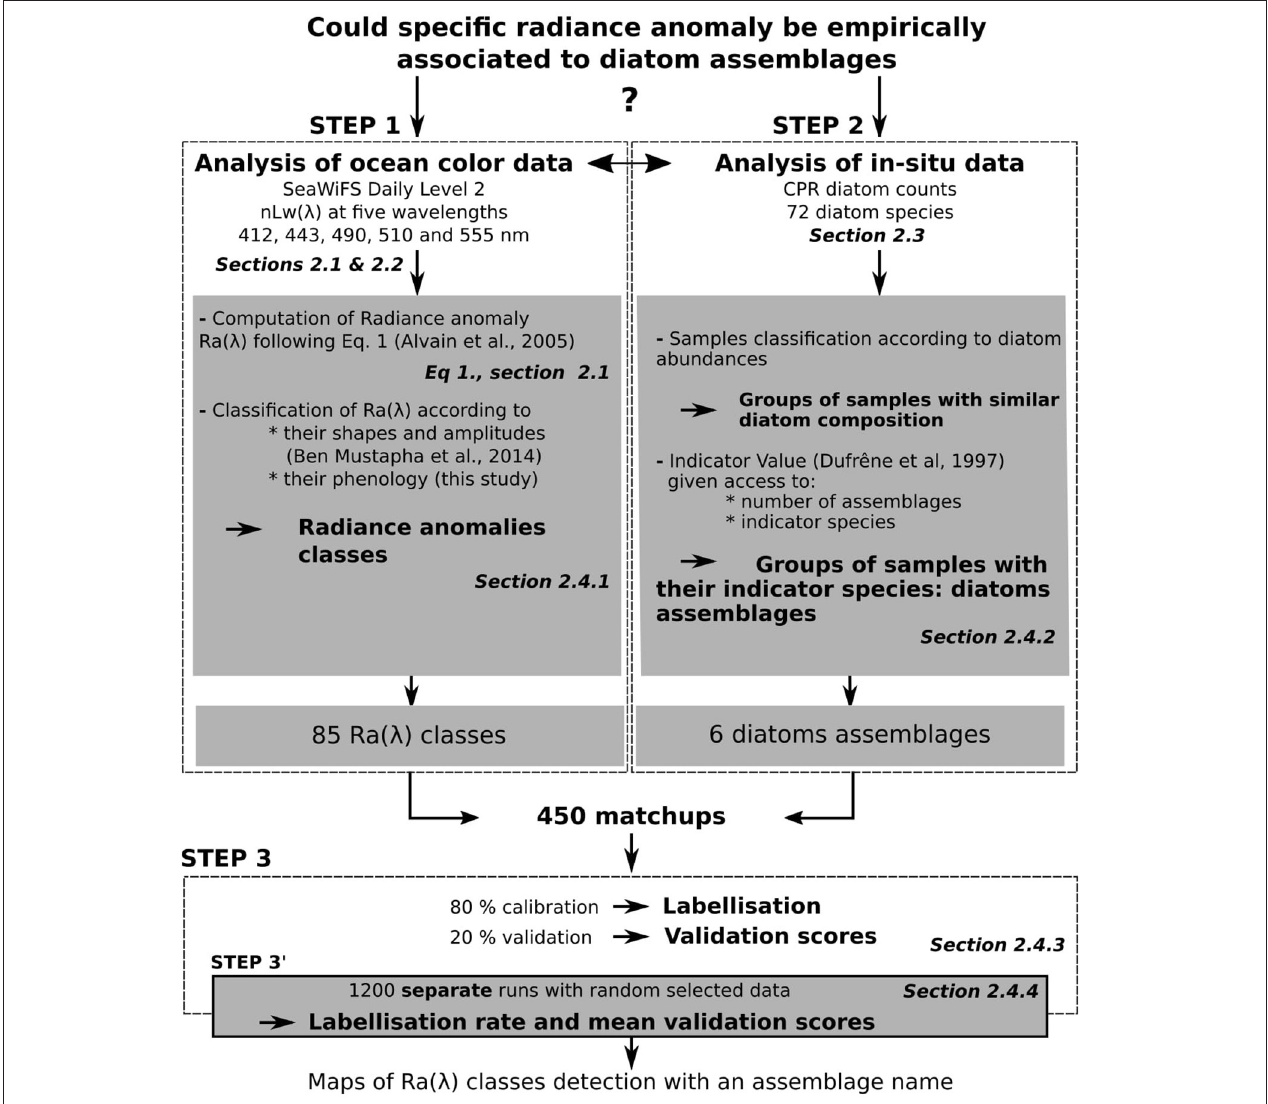
FIGURE 2 | Diagram of the processing steps followed in this paper. For each step, the associated Section(s) is displayed in italic. The three main steps are framed with dotted lines. The first step involved the processing of remote-sensing data; the second step involved the processing of CPR data and the third step involved the test of association between the results of steps one and